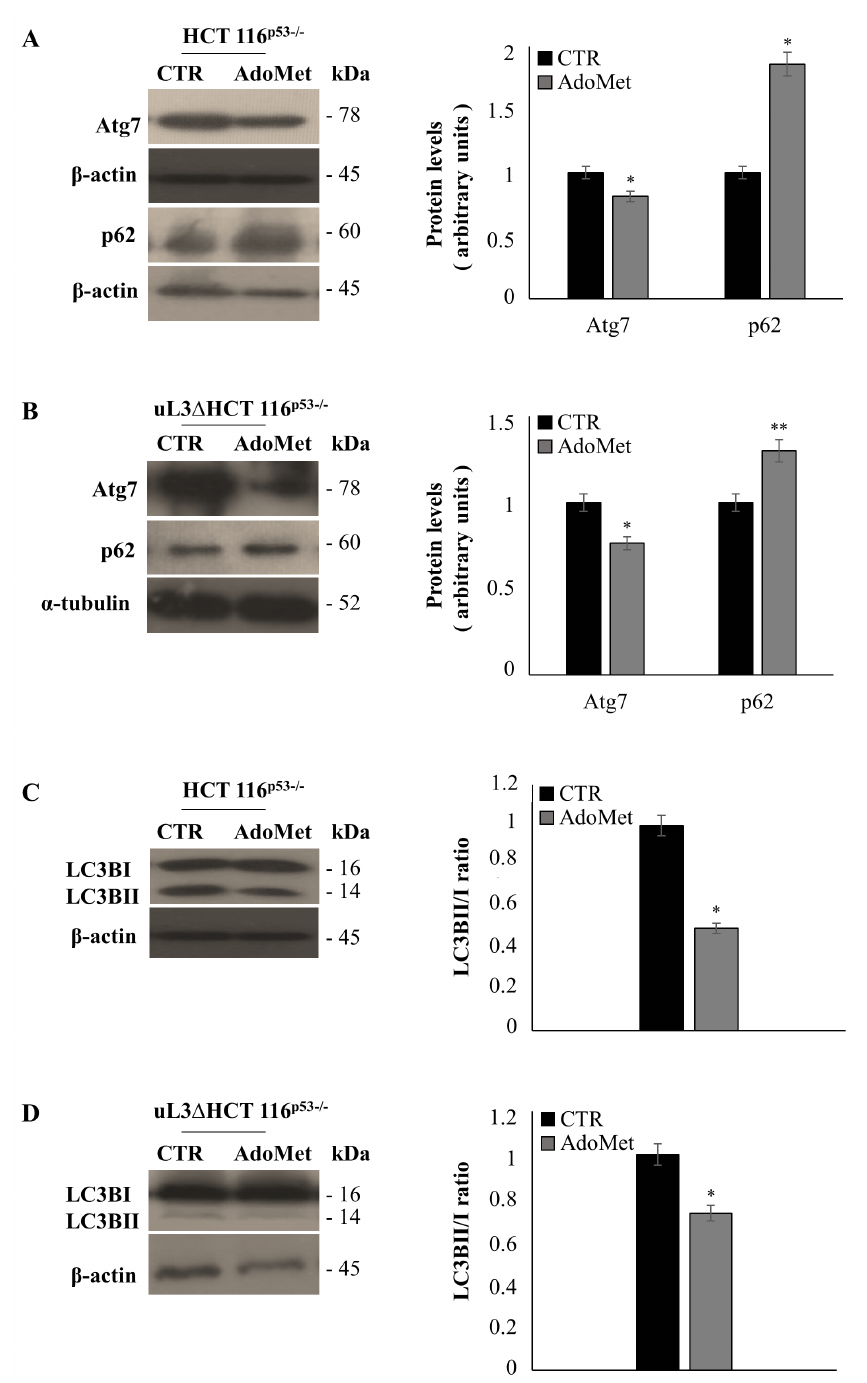
Figure 6. Effect of AdoMet on the autophagy related markers in HCT 116 p53 − / − and uL3 ∆ HCT 116 p53 − / − colon cancer cells. Representative immunoblotting of ATG7, p62, and LC3BI/II in HCT 116 p53 − / − cells ( A , C ) and uL3 ∆ HCT 116 p53 − / − cells ( B , D ) treated or not with 500 µ M AdoMet for 48 h. The housekeeping protein β -actin was used as a loading control; graphs show the relative densitometric analyses, expressed as arbitrary units. Quantification of the LC3B-II/I ratio is shown in the graphs. Bars represent the mean of triplicate experiments; error bars represent the standard deviation. * p < 0.05, ** p < 0.01 vs. untreated cells set at 1. Full-length blots are shown in Figure S3. These findings confirm the inhibitory effect of AdoMet on autophagic flux in both colon cancer cell lines.